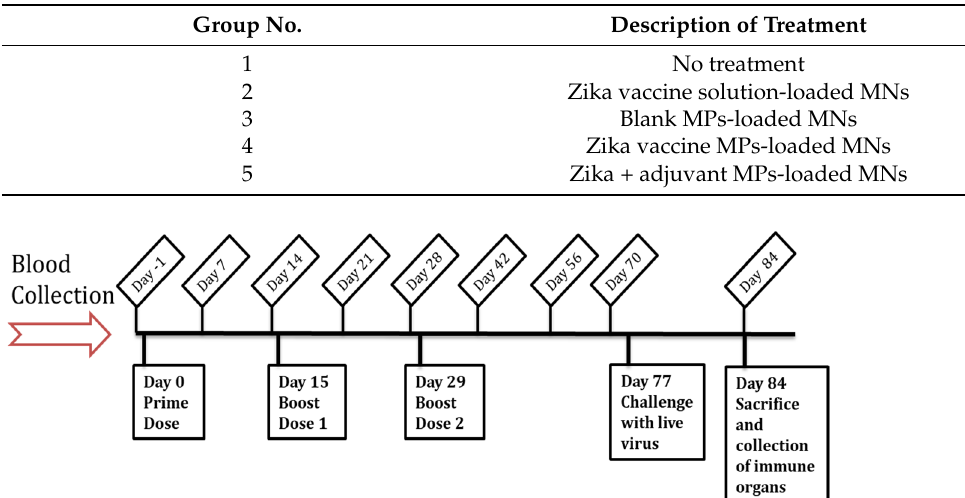
Table 1. Description of groups of mice in the in vivo efficacy evaluation of Zika vaccine MPs-loaded dissolving MNs (n = 5 per group).